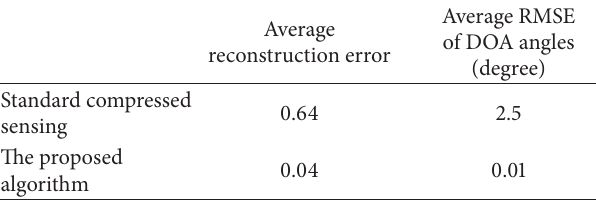
Figure 6: Histogram of the absolute off-diagonal entries of 𝐺 󸀠 based on the new sensing matrix, using a fixed threshold 𝑡 = 0.6 . Table 1: Performance